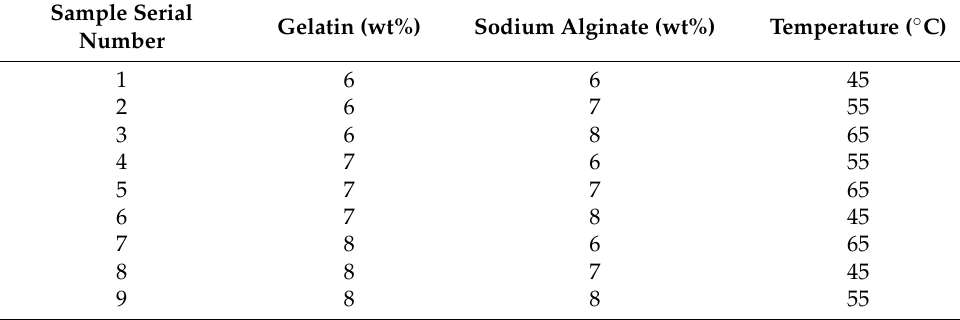
Table 5. Factors and levels of orthogonal text ( n =